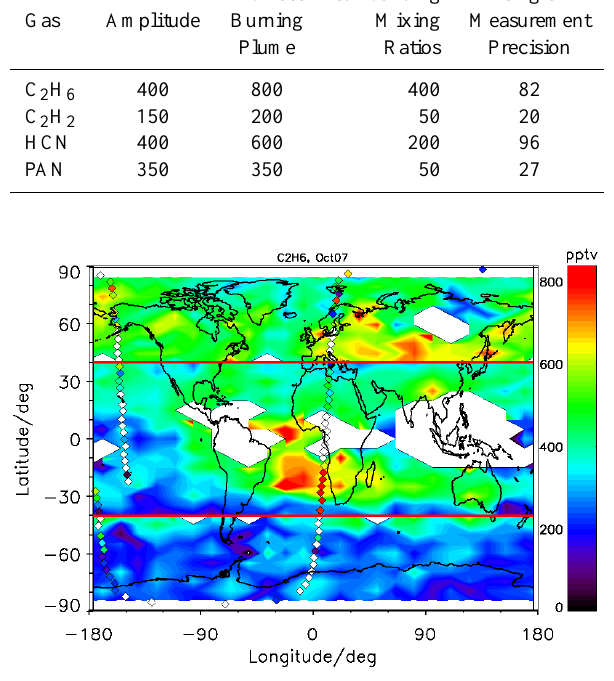
Fig. 10. Global monthly means of C 2 H 6 vmr for October 2007. Be- tween the red lines (40 ◦ N and S) C 2 H 6 vmr is shown at 12km, at latitudes poleward of 40 ◦ at 8km. This display is chosen to repre- sent the upper troposphere at all latitudes. The monthly means are calculated for latitude-longitude bins of 5 times 15 ◦ . The symbols mark the location of the C 2 H 6 single orbit plot figured above. The colours of the symbols represent the mixing ratios along the sin- gle orbit measurements at 12 or 8km depending on latitude. White symbols or areas indicate either mixing ratios below zero or cloud